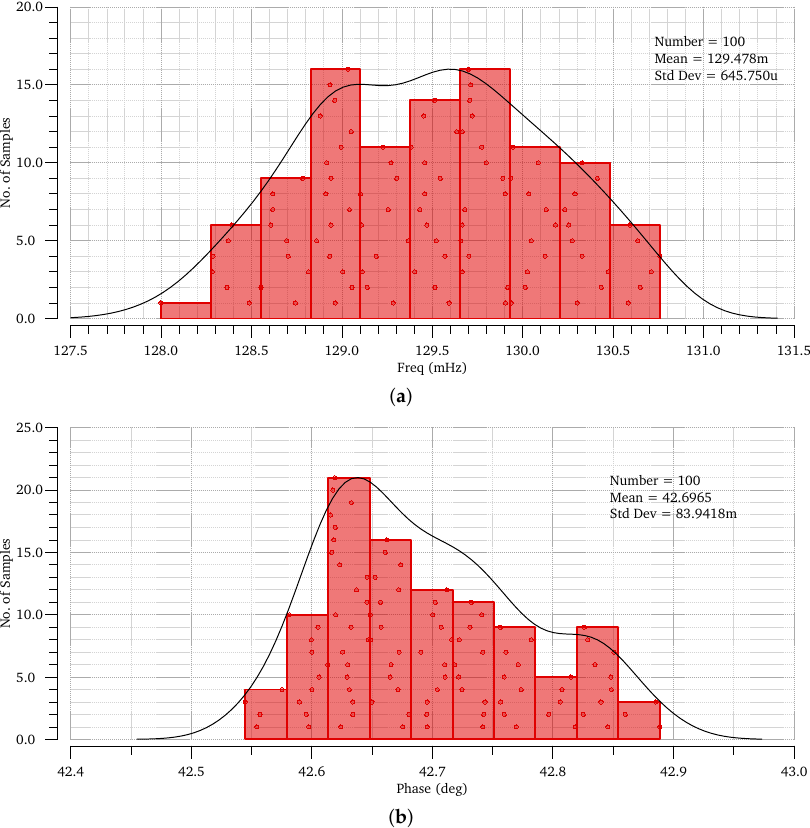
Figure 9. Sensitivity performance of the ( a ) gain crossover frequency, and ( b ) phase margin derived using Monte Carlo